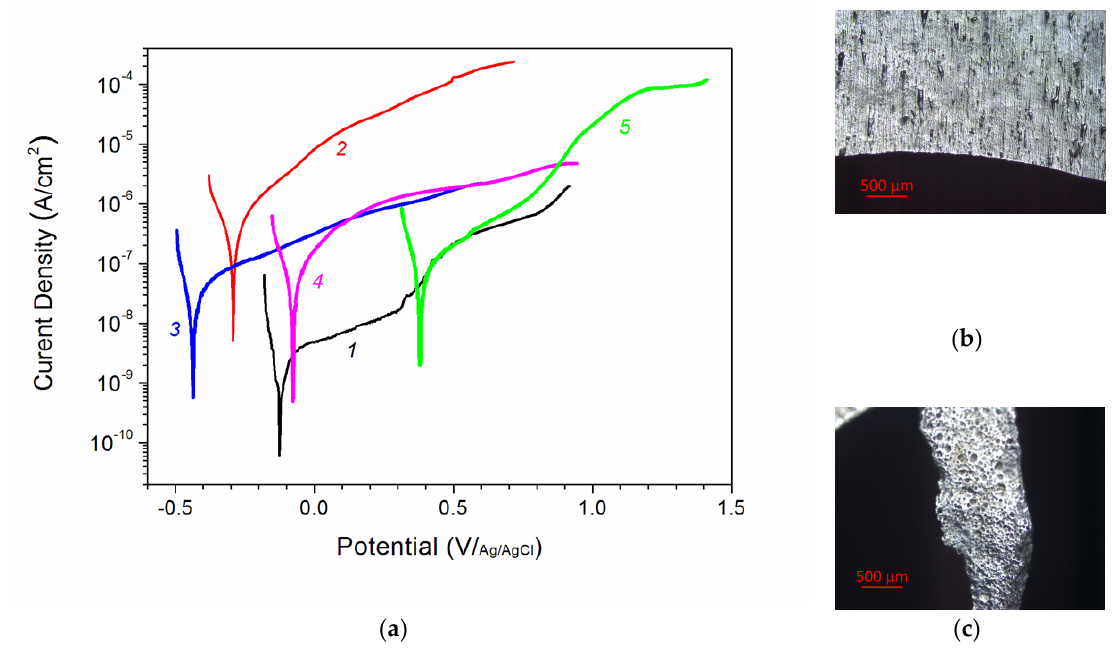
Figure 3. ( a ) Linear polarization curves (scanning rate 1 mV s − 1 ) for the amorphous Fe70Cr15B15 alloy electrode in the 0.1 M Na 2 SO 4 solution: 1 -initial, 2 -after the treatment of the alloy with a benzoic acid bu ff er in acetone (0.013 M), 3 -after the treatment with a benzoic acid bu ff er in acetone (0.013 M) followed by anodic oxidation in IL at i = 12.5 mA cm − 2 for 100 s, 4 -after mechanical abrasion, and 5 -after mechanical abrasion followed by anodic oxidation in IL at i = 12.5 mA cm − 2 for 100 s; Optical photo images of: ( b ) initial amorphous Fe70Cr15B15 alloy and ( c ) Fe70Cr15B15 amorphous alloy pretreated with BB in acetone followed by the electrochemical oxidation in the 0.1 M Na 2 SO 4 aqueous aerated solution.